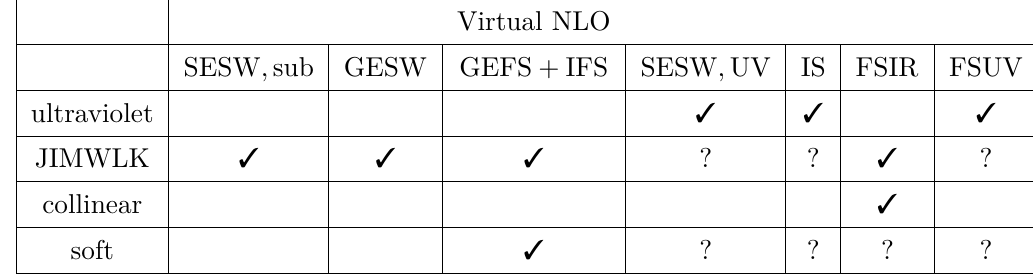
Table 2 . Overview of the possible divergencies or large logarithms encountered in our calculation, for the different virtual NLO contributions to the cross section. IS stands for all the initial-state virtual corrections, which were already obtained in ref. [100] and are not recalculated here. FSIR and FSUV , related to the self-energy corrections in the final state, are not calculated in section 3 neither, but are introduced in section 4. Just like the real contributions involving an instantaneously created gluon ( RI , RI and interferences), the virtual diagram ISW with an instantaneously emitted gluon does not exhibit any singularity or large logarithm, and hence merely contributes to the finite part of the cross section. Note that all contributions in the above table, except for IS , FSIR , and FSUV , have a q ↔ ¯ q counterpart with the same singularity structure. The contributions SESW , UV , IS , and FSUV exhibit soft- or rapidity singularities, between which we cannot make a distinction, although their combination is finite (see section 4).